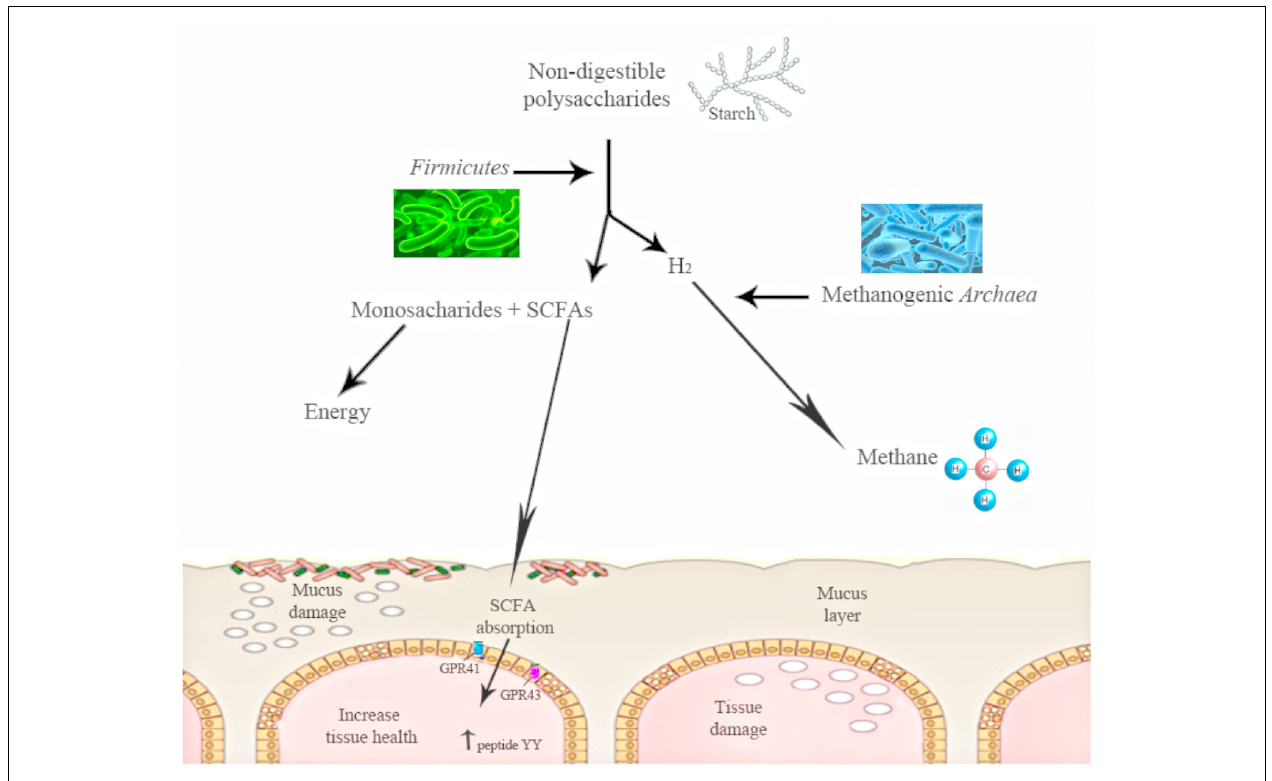
FIGURE 1 |The action of gut microbiota is needed to digest some polysaccharides. Gut microbiota converts polysaccharides into monosac- charides and short-chain fatty acids (SCFA).These SCFAs are able to bind and activate two G-protein-coupled receptors (GPR41 and GPR43) of the gut